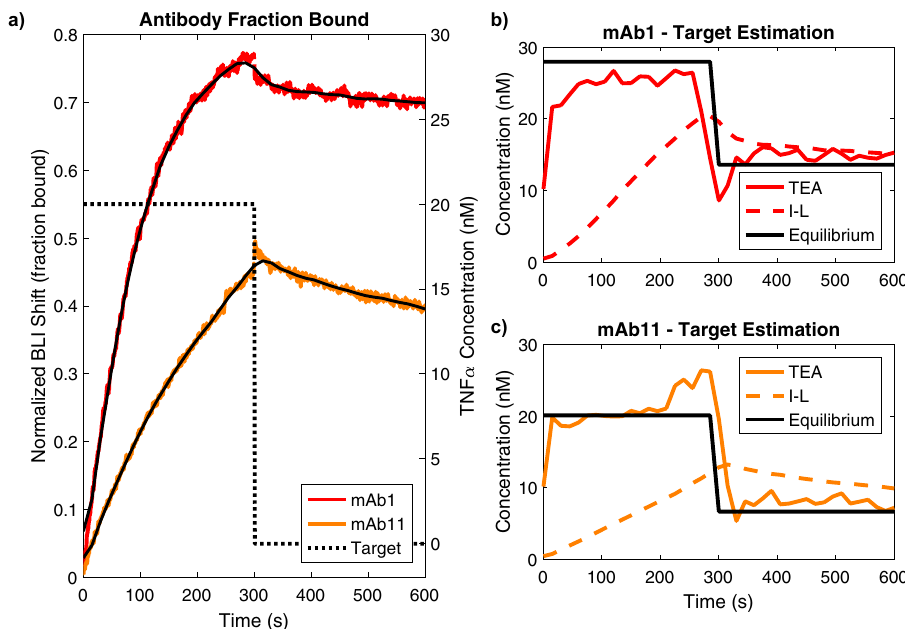
Fig. 3 | Experimental proof of principle. a Normalized biolayer interferometry (BLI)bindingdatafortwomonoclonalantibodies,mAb1(red)andmAb11(orange), exposedto20nMTNF α from0 – 300sand0nMTNF α from300 – 600s.Blacklines represent digitally low-pass fi ltered data. The target concentration was estimated